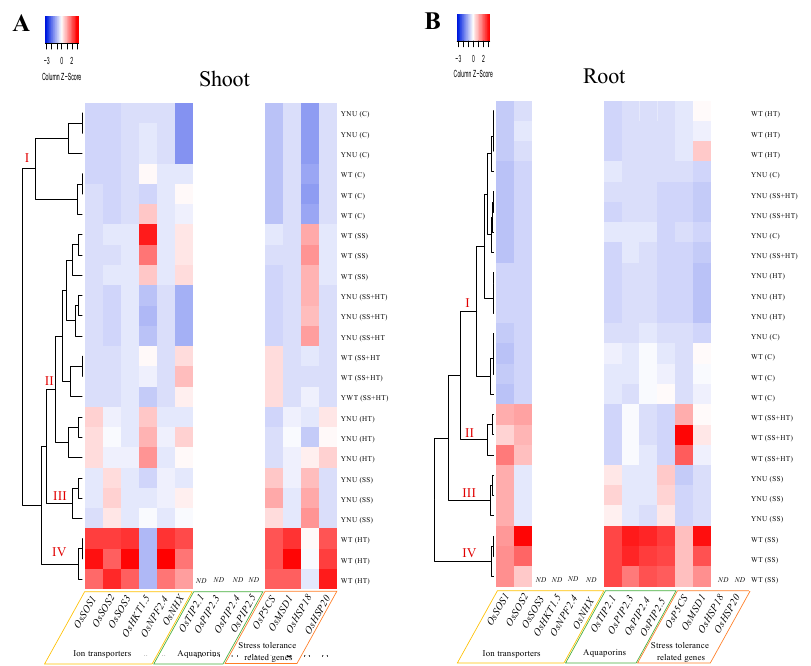
Figure 6. Hierarchical clustering analysis (HCA) of the relative transcript level of ion transporters, aquaporins, and stress-related genes in ( A ) shoot and ( B ) root tissues of WT and YNU seedlings under control (C: 26/23 °C, 0 mM NaCl), salt stress (SS: 26/23 °C, 75 mM NaCl), high-temperature (HT: 30/26 °C, 0 mM NaCl), and combined salinity and heat (SS + HT: 30/26 °C, 75 mM NaCl) conditions. Kendall’s Tau and Average linkage were used as distance measurement and clustering methods, respectively. ND: not detected.